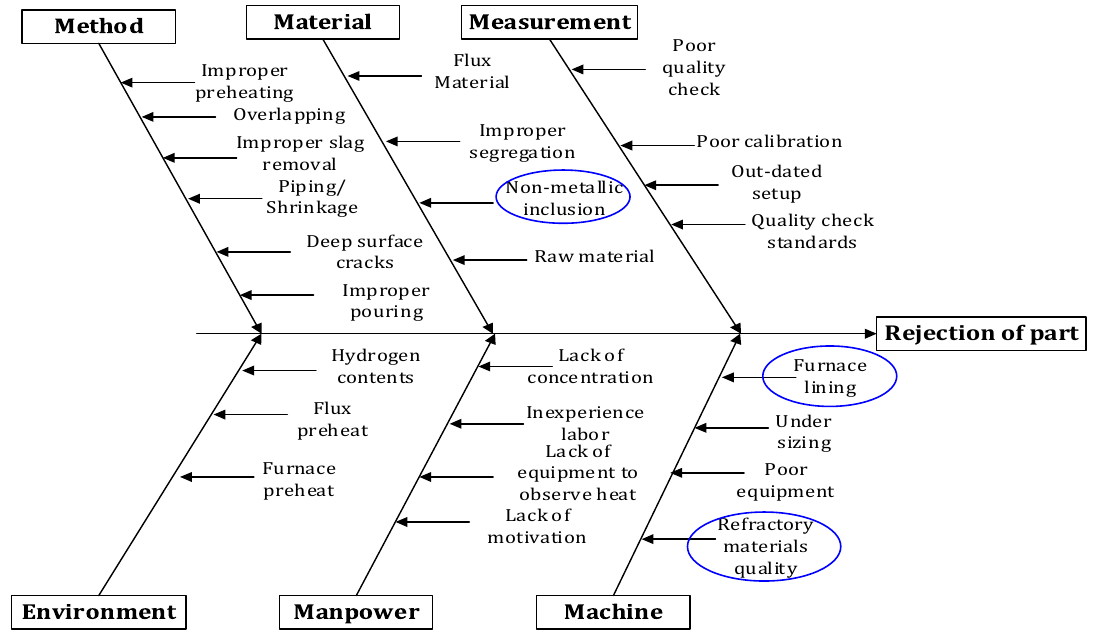
ff ect diagram highlighting the causes of shaft Figure 12. Cause and effect diagram highlighting the causes of shaft rejection. Figure 12. Cause and e